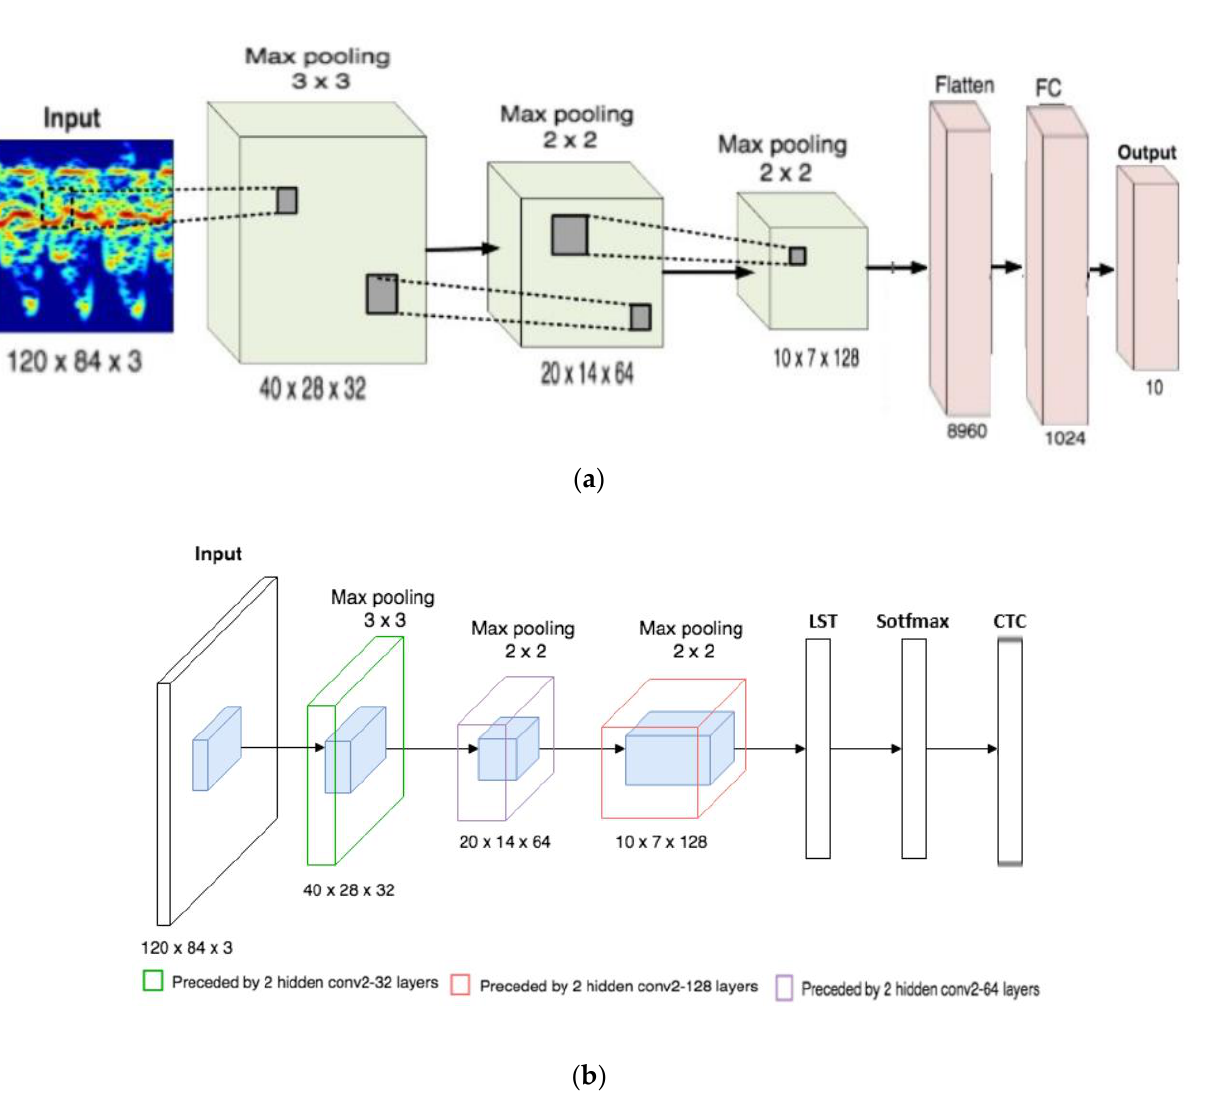
Figure 3. ( a ) Proposed double machine learning algorithm: a convolution including a multilayer perceptron ( left ); ( b ) Proposed double machine learning algorithm: 3D-CNN encompassing dedicated routines based on LSTM, Softm and CTC.